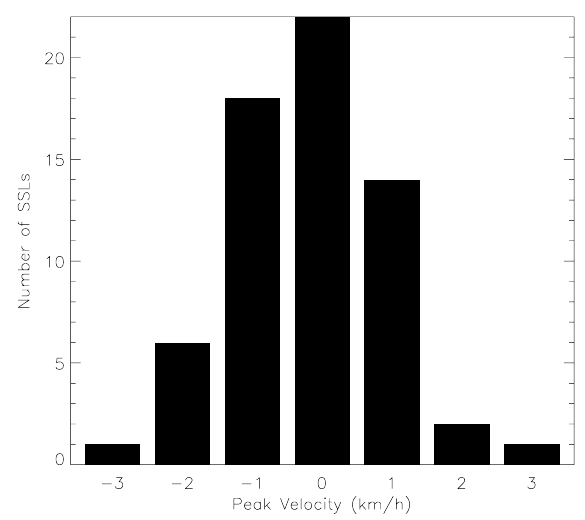
Fig. 5. Statistical plot of the average velocity of the SSL peaks trajectories. Positive and negative values represent the upward and downward motions of SSL peaks,